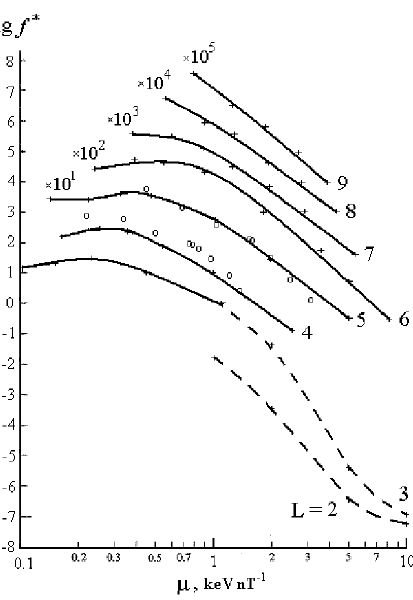
Figure 3. The functions f ∗ (L , µ) , as in Eq. (2), for a quiet pro- ton belt constructed according to Williams (1981) for ISEE-1 (thick curves), Fritz and Spjeldvik (1981) for Explorer-45 (light circles) and Albert et al. (1998) for CRRES (dotted curves).